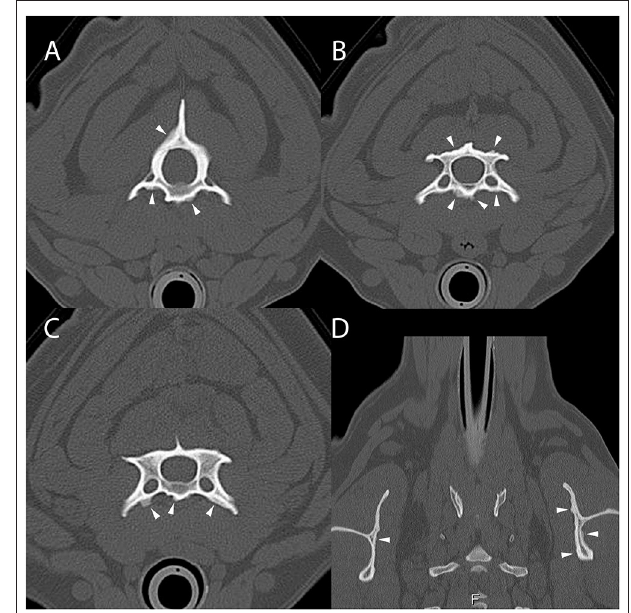
FIGURE 1 | Example of suspected lesions of American canine hepatozoonosis. Post-contrast transverse images at the level of the sixth cervical (A) , second thoracic (B) , fifth thoracic (C) , and tenth thoracic vertebrae (D) in a in a 2 year-old female spayed miniature Australian shepherd dog who tested positive for Hepatozoon americanum polymerase chain reaction. In all images, there is multifocal, irregularly marginated, periosteal proliferation on several non-articular surfaces of the axial skeleton (white arrowheads). There is no lysis of cortical bone in any image. In (A) , the ventral vertebral body and transverse processes are asymmetrically affected. The medial aspect of both scapulae have smooth periosteal proliferation that has organized to form a pseudocortex. In (B) , the periosteal proliferation of the spine of the right scapula appears similar to the lesions on the ribs and vertebrae. The second pair of ribs have mild lesions. In (C) , the left fifth rib has multifocal regions of irregular periosteal proliferation on the medial surface, while in (D) there is periosteal proliferation of the dorsal surface of the tenth ribs. There is no contrast enhancement seen in the soft tissues surrounding the periosteal proliferations.